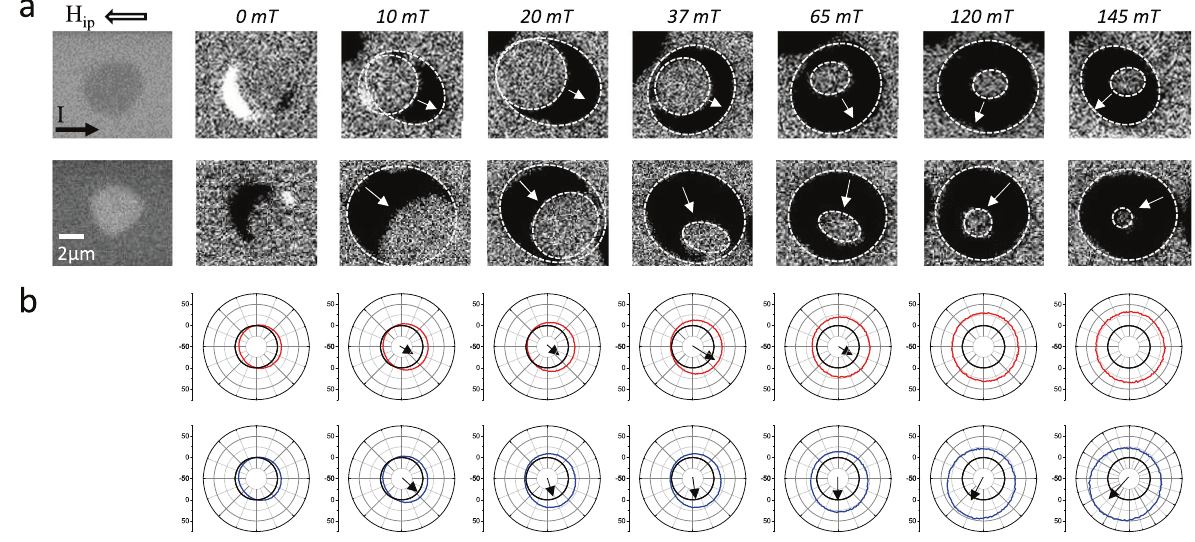
Fig. 4 Chiral distortion of skyrmionic bubbles. a . Kerr images of the bubble displacement under the effect of current pulses (20 ns at 1·10 8 A/cm 2 ) and H ip . On the fi rst row we show images of a bubble magnetized up, on the second row, a bubble magnetized down. The fi rst column shows the direct image of the initial bubble prepared by applying H Z . The rest of the columns show differential images of displacements induced by the current for different values of H ip (from left to right: 0, 10, 20, 37, 65, 120, 145 mT). White dotted lines indicate the contours of the initial and fi nal bubble. The white arrows point towards the direction of bubble displacement. The number of pulses is different for each image (top: 5000; 30,000; 10,000; 2000; 1500; 360; 120; bottom: 20,000; 50,000; 2500; 5000; 400; 100; 100;). b . Polar plot of computed DW velocity as a function of the angle between the DW orientation and electric current, corresponding to the same current density and H ip values as the experimental data. In the top row, we show in red results from a scenario with DMI but without α c . The bottom row shows in blue results including both α c and DMI. From the velocity dependence, we extract the direction of bubble displacement indicated by the black arrows. They are in agreement with the white arrows on the MOKE images that indicate the experimental bubble